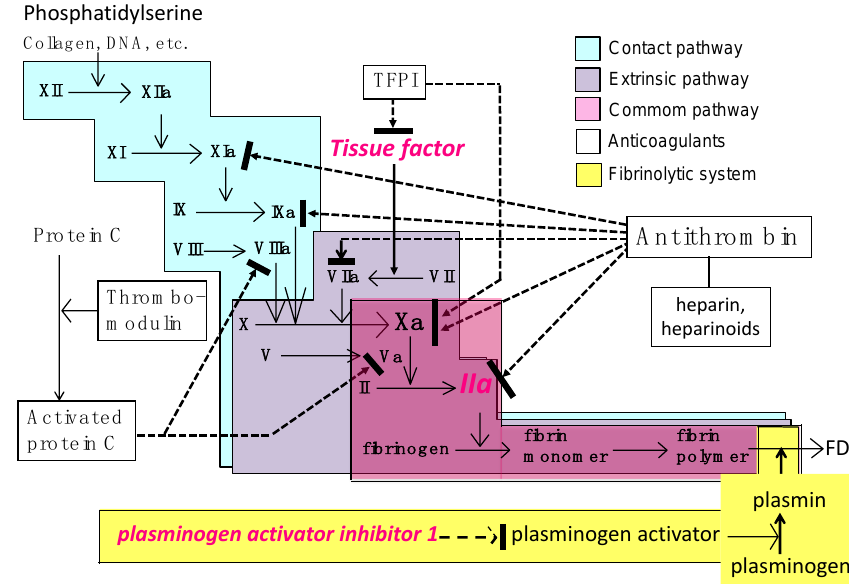
Figure 2. The coagulation, fibrinolytic, and natural anticoagulant systems. Both the extrinsic pathway and contact pathway are activated in sepsis. Tissue factor, expressed on the monocytes, endothelial cells, and extracellular vesicles triggers the extrinsic pathway, while the phosphatidylserine residue present in various cell membranes initiates the contact pathway of coagulation. Antithrombin / heparin, thrombomodulin / protein C, and tissue factor pathway inhibitor (TFPI) are the three major physiologic anticoagulant systems. FDP: fibrin / fibrinogen degradation products.